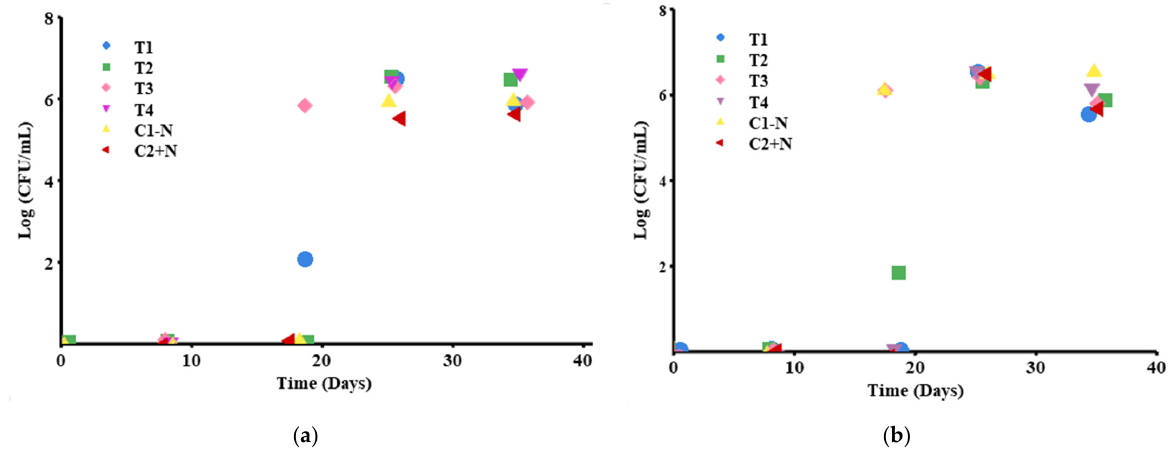
Figure 6. Microbiological characteristics of biopreserved T1–T4 chorizo and controls: ( a ) microbiological count of LAB (MRS); ( b ) microbiological count of mesophiles (PCA).